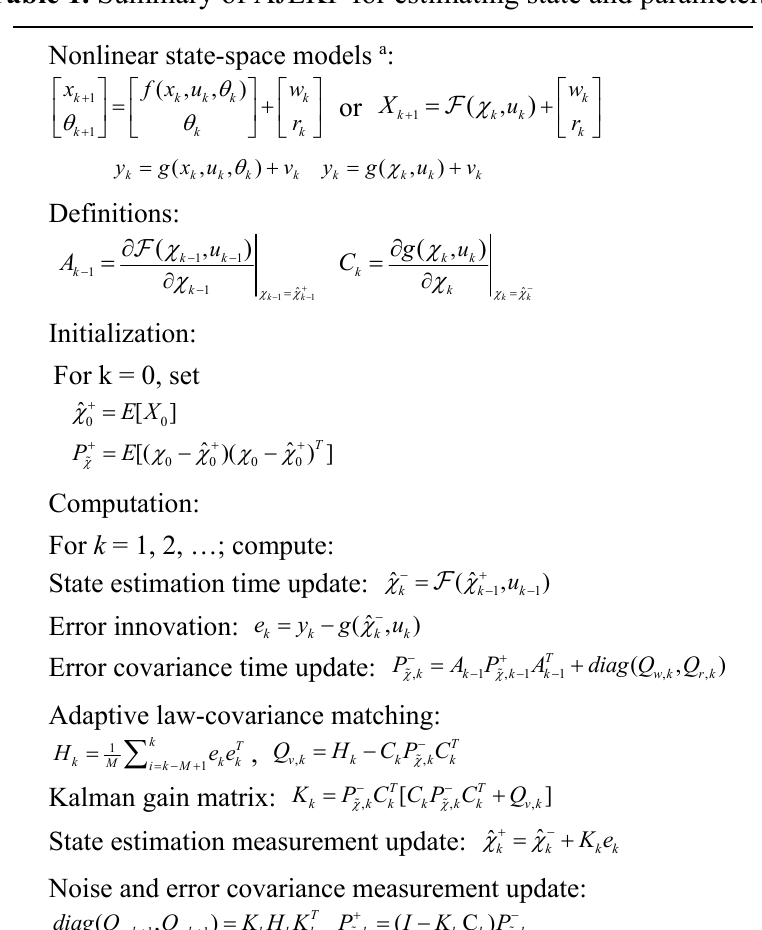
Table 1. Summary of AJEKF for estimating state and